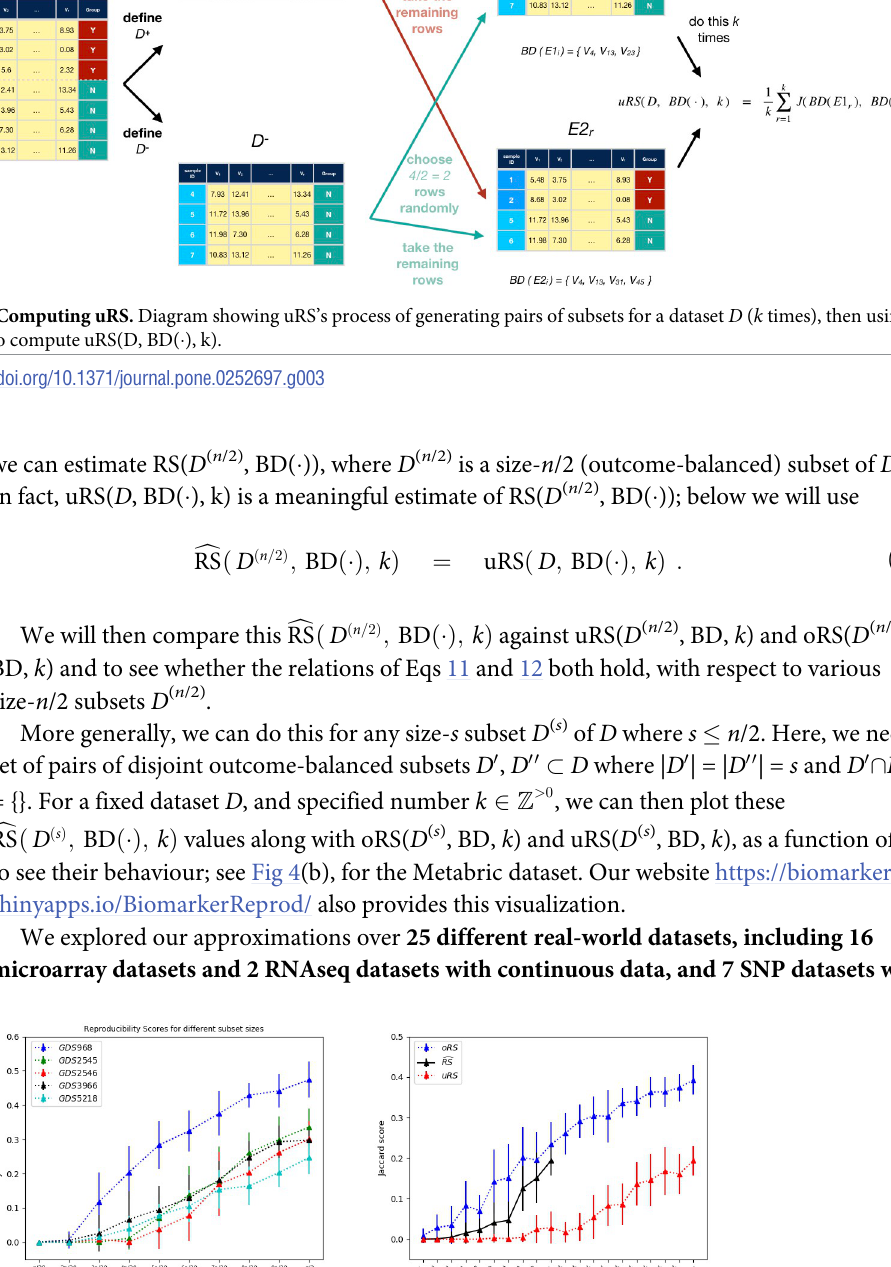
t , 0.05, BH . (b) Showing